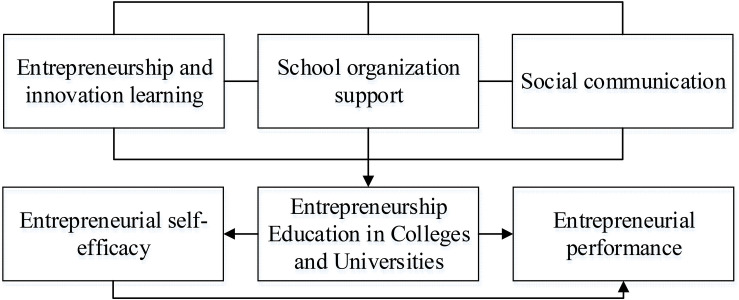
Model construction.